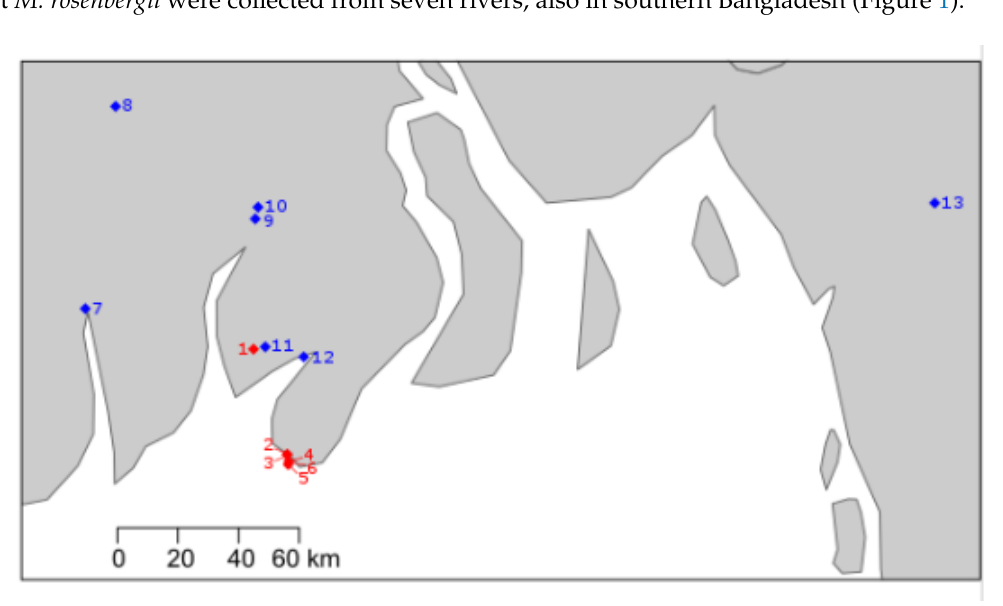
Figure 1. Map of the southern Bangladesh coastline (sea in white, land in grey) with sampling site locations. Hatcheries denoted with a red diamond (1–6) and river sampling sites denoted with blue diamond (7: Shibsa River, 8: Rupsa River, 9: Katcha River, 10: Kocha River, 11: Biskhali River, 12: Payra River, 13: Karnaphuli